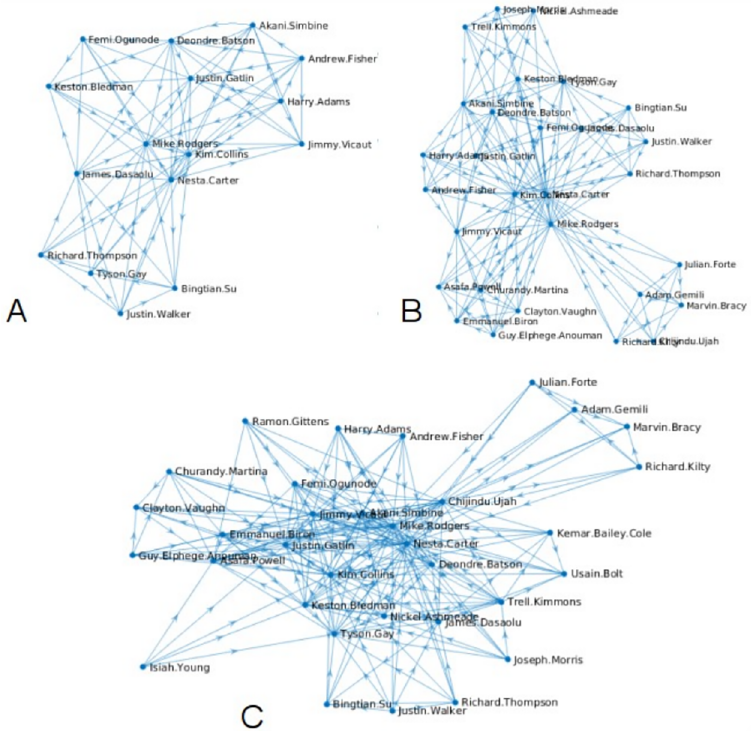
Fig 3. Connectivity networks between athletes after: (A) the first three races; (B) the first six races; and (C) all ten races.